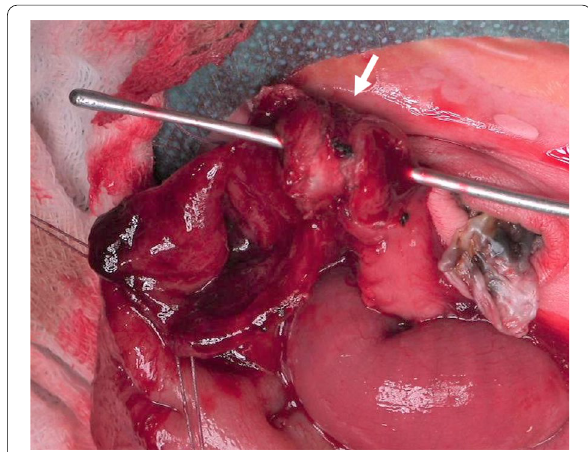
Fig. 2 Macroscopic findings from surgery. Intraoperative findings were the napkin ring appearance at transvers colon (white arrow). A bowel incision was made in the vicinity of the stenosis to see if a sonde could pass through the stenosis. A partial resection and end-to-end anastomosis were